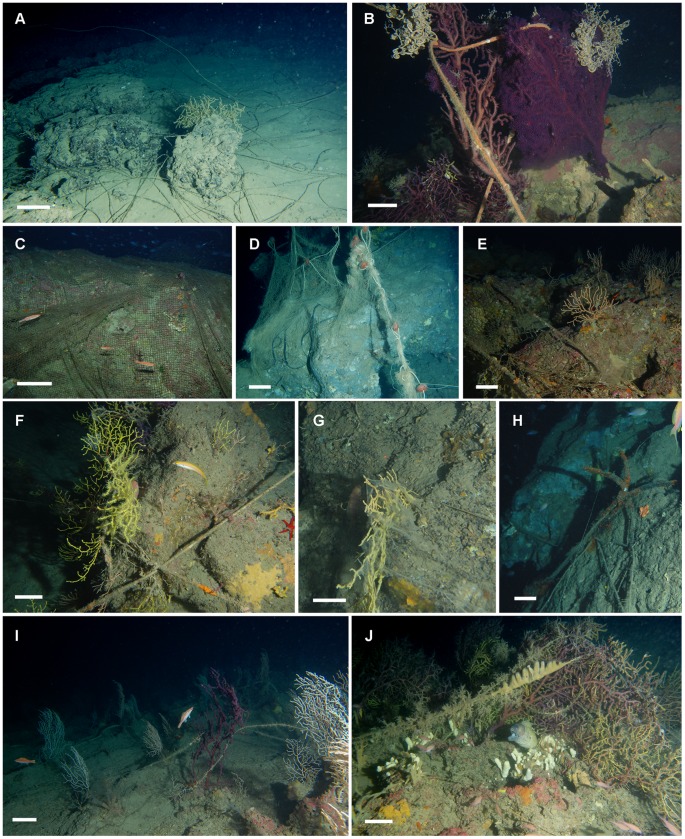
Impact of the fishing activity on the rocky shoals of St. Eufemia.A) Rocky boulders entrapped by lost long lines hosting colonies of Bebryce mollis. B) Colonies of Paramuricea clavata hosting the ophiuroids Astrospartus mediterraneus entangled by a rope peeling off the coenenchyme of the gorgonians. C–D) Ghost nets entirely wrapping rocky boulders. E) Lost net stretched over a population of Eunicella cavolinii. F–G) Abandoned long lines and plastic sheet entrapped in colonies of P. clavata. H) Abandoned anchor on the sea-floor. I) Lost lines stretching between a mixed assemblage of E. cavolinii and P. clavata. J) Old lines entangling colonies of P. clavata and covered by various epibionts such as sertulariid hydroids and ascidians. Scale bar: A, D: 20 cm, B–C, E–J: 10 cm.